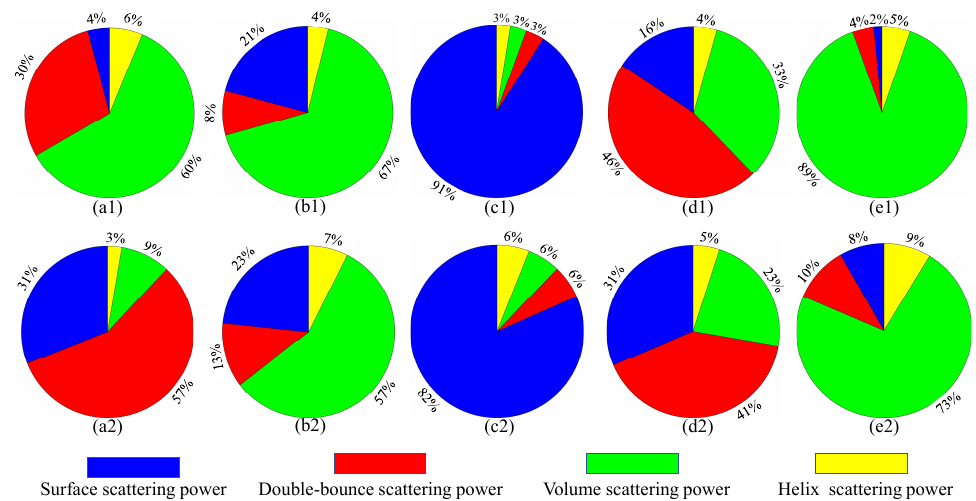
Figure 28. Comparison of the scattering mechanism of different land covers with different sensors. ( a1 , a2 ) are High-density urban . ( b1 , b2 ) are Vegetation . ( c1 , c2 ) are Water . ( d1 , d2 ) are Developed urban . ( e1 , e2 ) are Low-density urban . ( a1 – e1 ) are the results of the AIRSAR sensor. ( a2 – b2 ) are the results of the RS2 sensor.